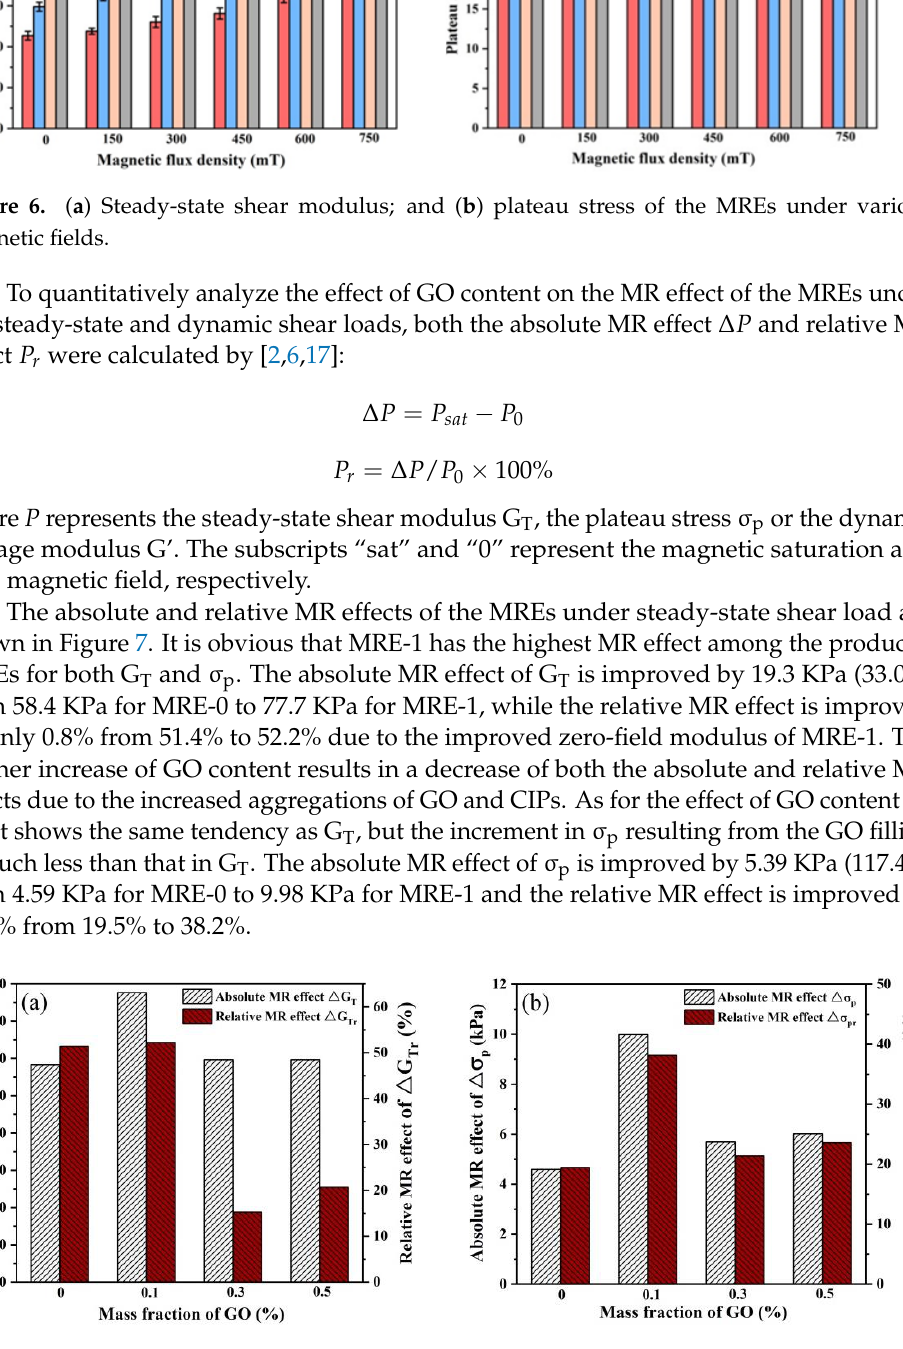
Figure 7. The absolute and relative MR effect of the MREs under steady-state shear load: ( a ) shear modulus; and ( b ) plateau